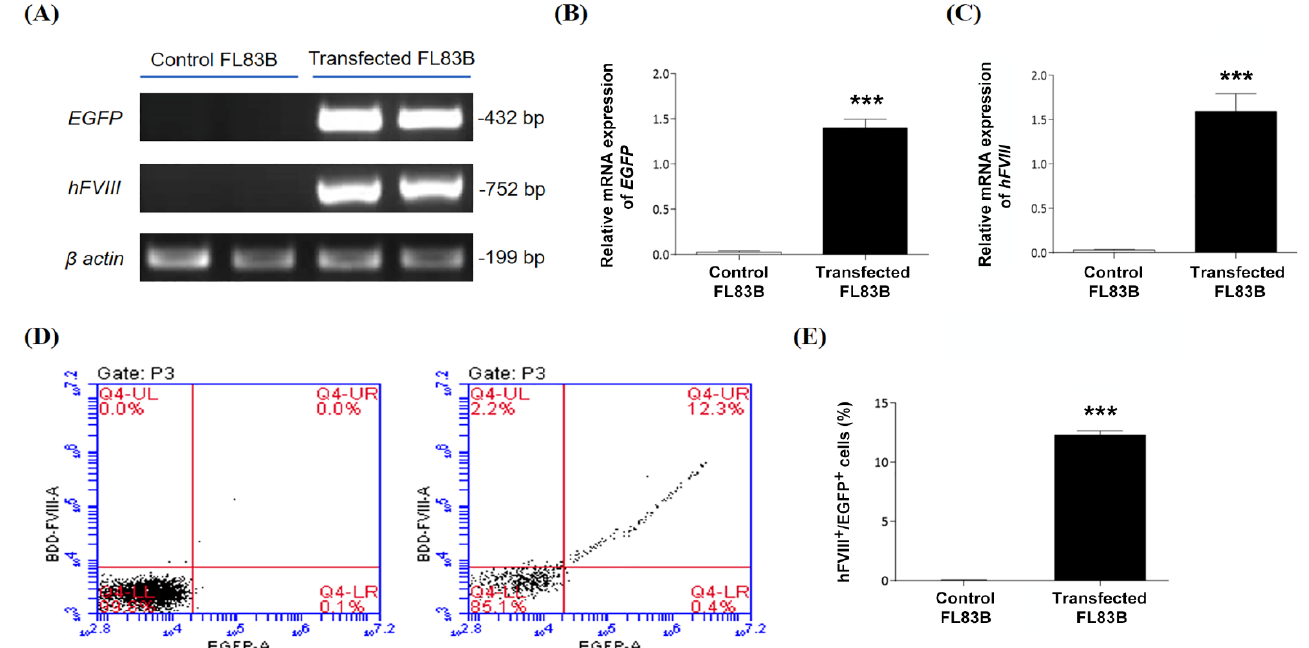
Figure 4. Assessment of PmAlb- BDD-FVIII -pCMV- EGFP plasmid DNA expression in normal mouse liver cells. ( A ) Representation of quantitative RT-PCR results of EGFP and hFVIII gene expression in FL83B cells after transfection with PmAlb- BDD-FVIII -pCMV- EGFP plasmid DNA for two days. Nontransfected FL83B cells were used as a negative control. A β -actin gene was used as an internal mRNA loading control. ( B ) Quantification of EGFP gene expression in FL83B cells transfected with (transfected group) or without (control group) PmAlb-BDD- FVIII -pCMV- EGFP plasmid DNA. ( C ) Quantification of human FVIII gene expression in FL83B cells transfected with (transfected group) or without (control group) PmAlb-BDD-FVIII-pCMV-EGFP plasmid DNA. ( D ) Flow cytometry analysis of EGFP and FVIII expression in FL83B cells after transfection of the PmAlb- BDD-FVIII plasmid DNA. Transfected cells were stained with anti-hFVIII antibody conjugated with Alexa Fluor ® 546 dye, and hFVIII and EGFP dual fluorescence-positive cells were analyzed by flow cytometry (right). Nontransfected FL83B cells were used as a negative control (left). ( E ) The percentage of both EGFP- and FVIII-positive cells in a total of 100,000 cells was quantified. Data are presented as the mean ± SD, *** p < 0.001 vs. the control group (two-tailed t